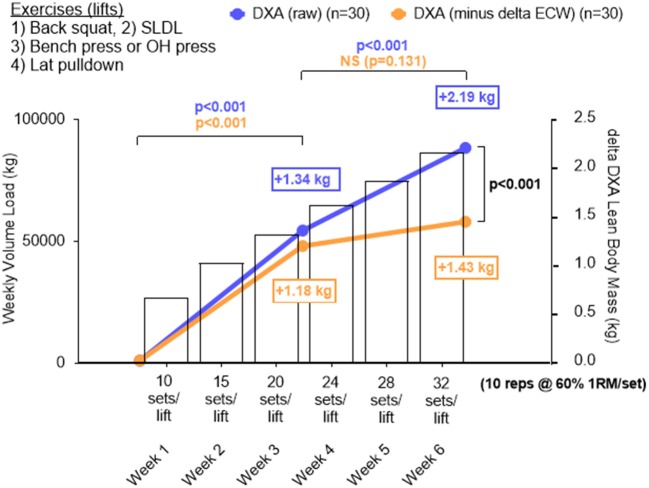
Change in DXA lean body mass plotted against increases in training volume for all participants. Data in this figure include DXA lean body mass changes (blue line graph), changes in LBM by subtracting changes in extracellular water (i.e., ECW-corrected ΔLBM), and training volume (bar data) from all 30 participants who underwent DXA and BIS testing. A significant increase in LBM from PRE to MID (p < 0.001) and MID to POST (p < 0.001) was observed in DXA LBM and this was proportional to the increase in training volume over time. When considering ECW-corrected ΔLBM changes, a similar increase occurred across groups from PRE to MID (p < 0.001), but the increase from MID to POST was not significant (p = 0.131). Additionally, POST DXA LBM was significantly higher than POST ECW-corrected ΔLBM. All data is presented as mean changes, and bars depicting standard deviation were left off of these panels in order to simplify the figure.